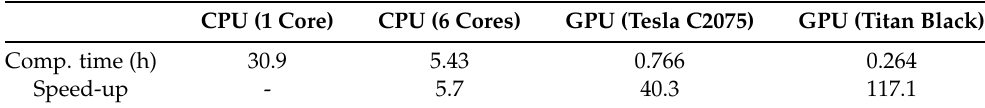
Figure 9. Case 2: Temporal evolution of the pipe water depth and flooding discharge at connections 5, 24 and 35. Table 1. Summary of the computational times for Case